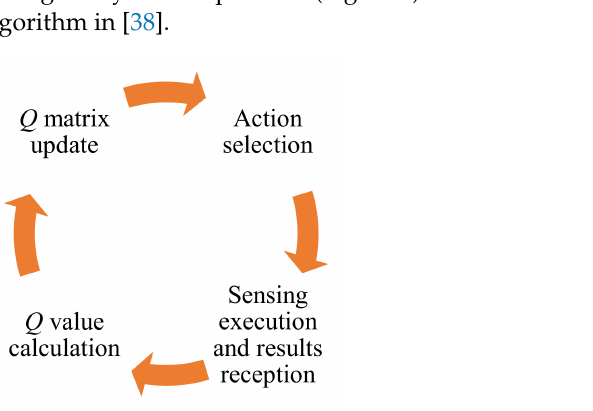
Figure 4. Radio channels utility evaluation algorithm—the cycle of subsequent